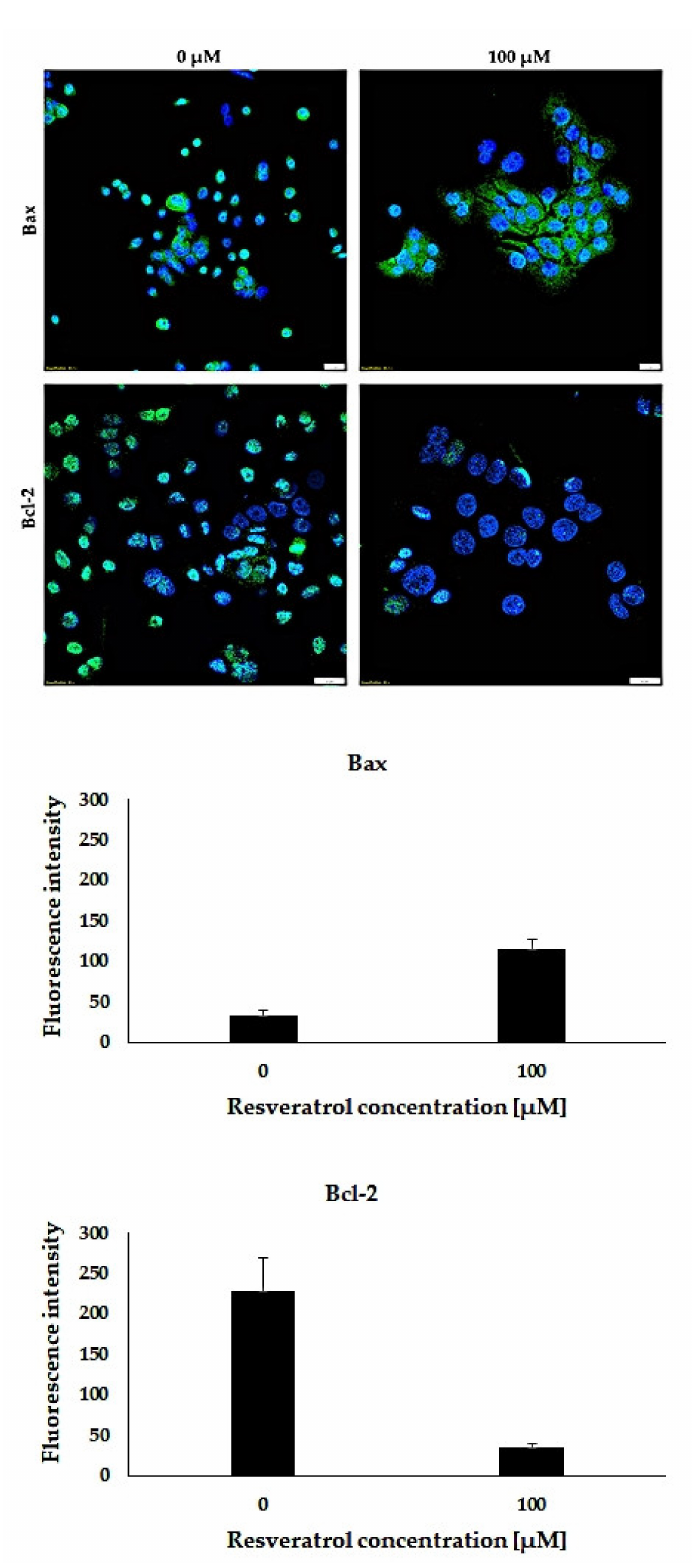
Figure 10. Confocal images showing changes in the level of the Bax and Bcl-2 proteins in the pancreatic cancer cell line AsPC-1 after treatment with 100 µ M of resveratrol. Magnification 60 × , scale = 20 µ